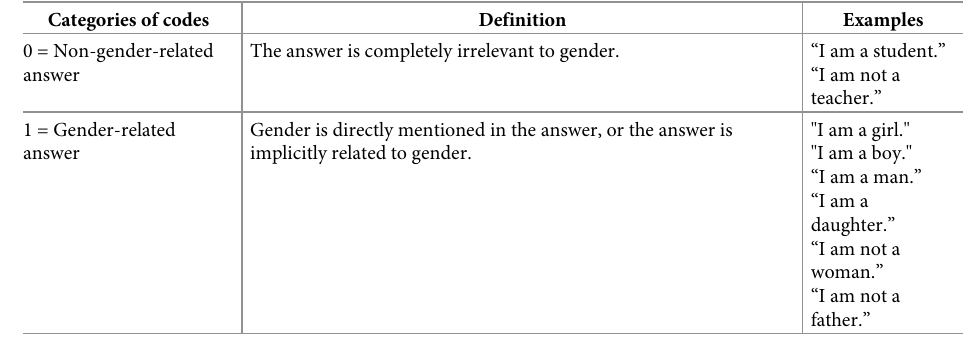
Table 2. Coding scheme of the gender salience measure adapted from McGuire et al.’s method